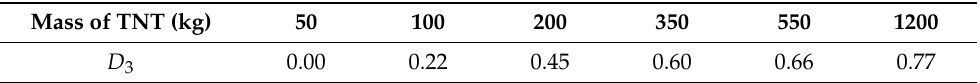
Table 4. The degree of damage to the abutment when subjected to an underwater contact explosion. Mass of TNT (kg) 50 100 200